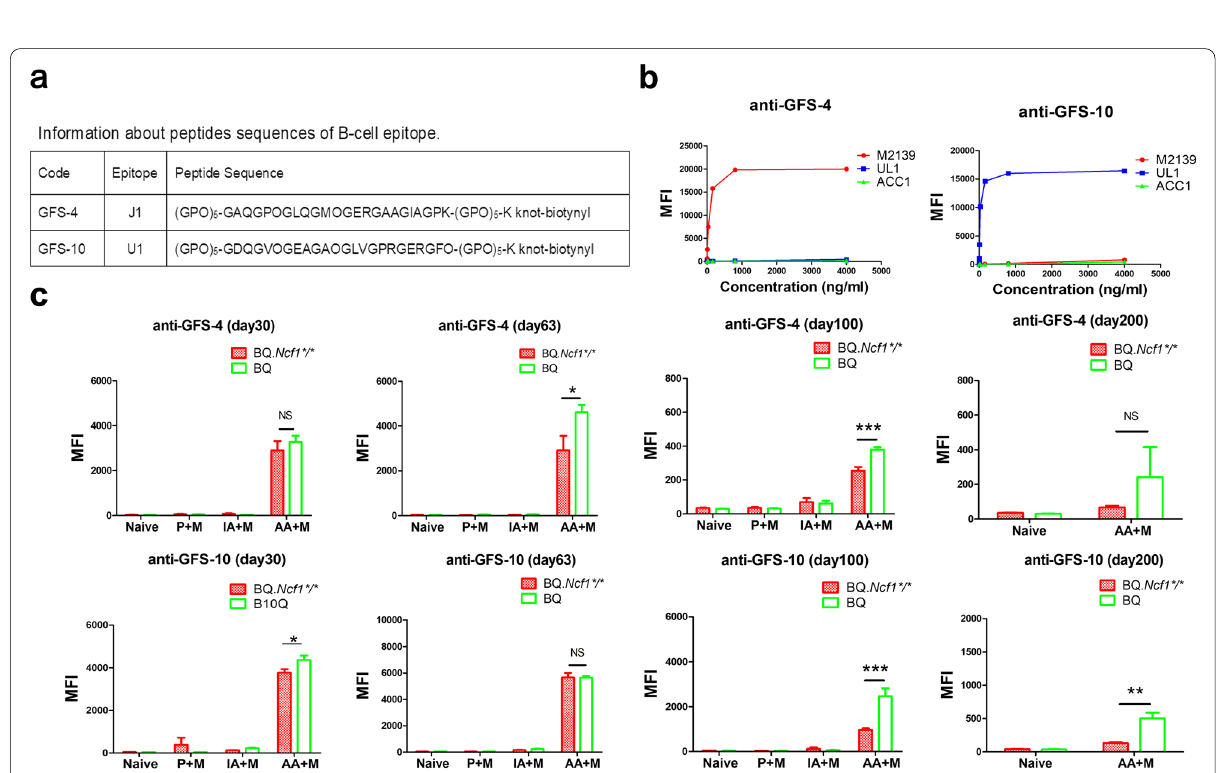
Fig. 6 M2139 and UL1 antibodies are not detectable in the chronic phase of arthritis in BQ. Ncf1 */* mice. The peptide sequence and the specificity of the injected antibodies (M2139 and UL1) are shown in ( a ) and ( b ), respectively. c The levels of M2139 and UL1 in the serum (1:50 dilution) from AA M, IA M, P M and naïve groups on days 30, 63, 100 and 200. The data shown are mean + + + to calculate the level of significance. BQ. Ncf1 */*